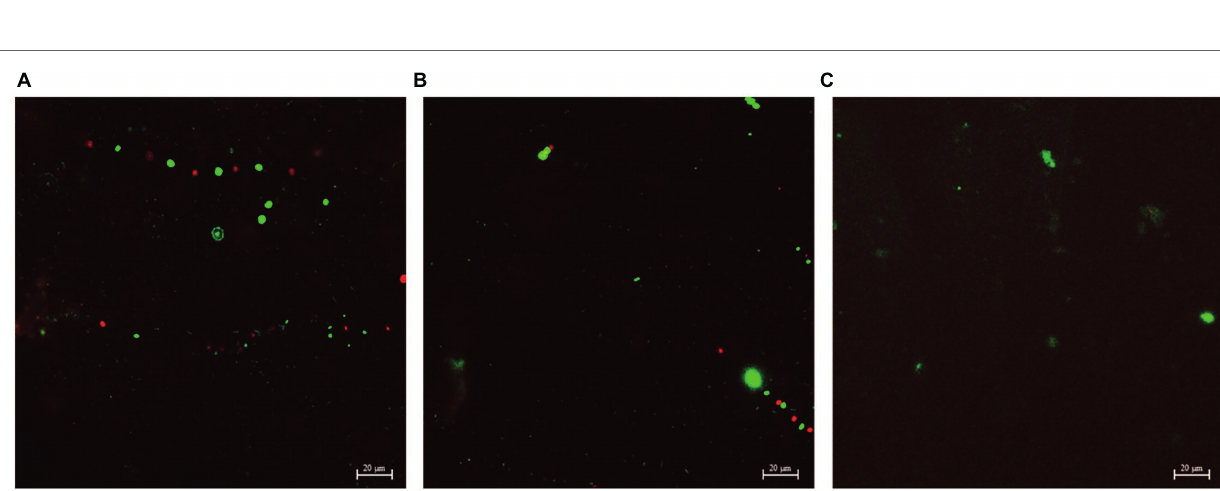
FIGURE 6 | CLSM biofilm images on 100 nm Ce-NiMo coatings with different electrocodeposition conditions after 21-day SRB incubation at 37 ° C: (A) [DC], (B) [low f ], and (C) [high f ].